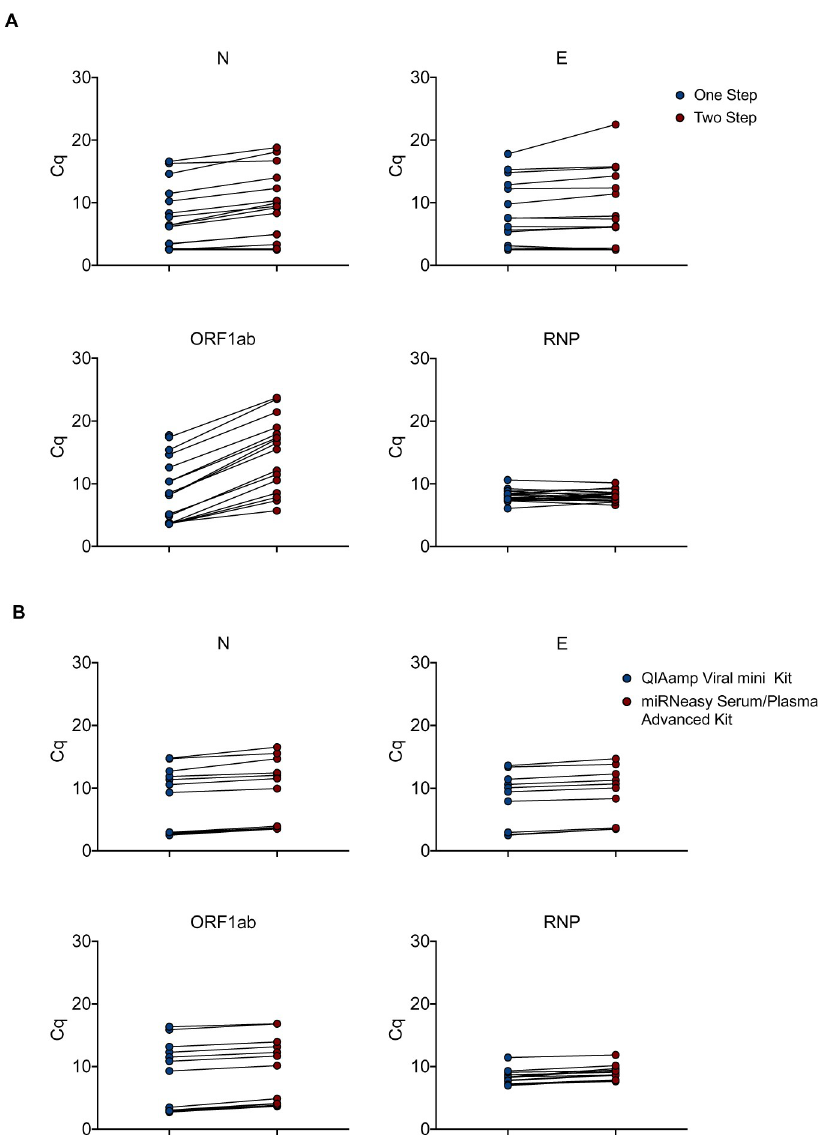
Fig 2. Optimization of the assay. (A) Total RNA from 18 clinical samples with a wide range of SARS-CoV-2 infection were subjected to either a Two-step reaction (red circles; consecutive Reverse Transcription and Pre-amplification) or One-step reaction (blue circles; combined Reverse Transcription and Pre-amplification). Quantitative PCR reactions were performed on the Biomark-HD using cellular (RNP) and viral (N, E, ORF1ab) primers/probe sets. (B) Total RNA from 18 clinical samples with a wide range of SARS-CoV-2 infection were extracted with either the miRNeasy Advanced Serum Plasma Kit (red circles) or the Virus QIAamp Viral RNA kit (blue circles). RNAs were processed using the One step reaction. Quantitative PCR reactions were performed on the Biomark-HD using cellular (RNP) and viral (N, E, ORF1ab) primers/probe sets. The Cq presented are representative of two independent experiments performed in